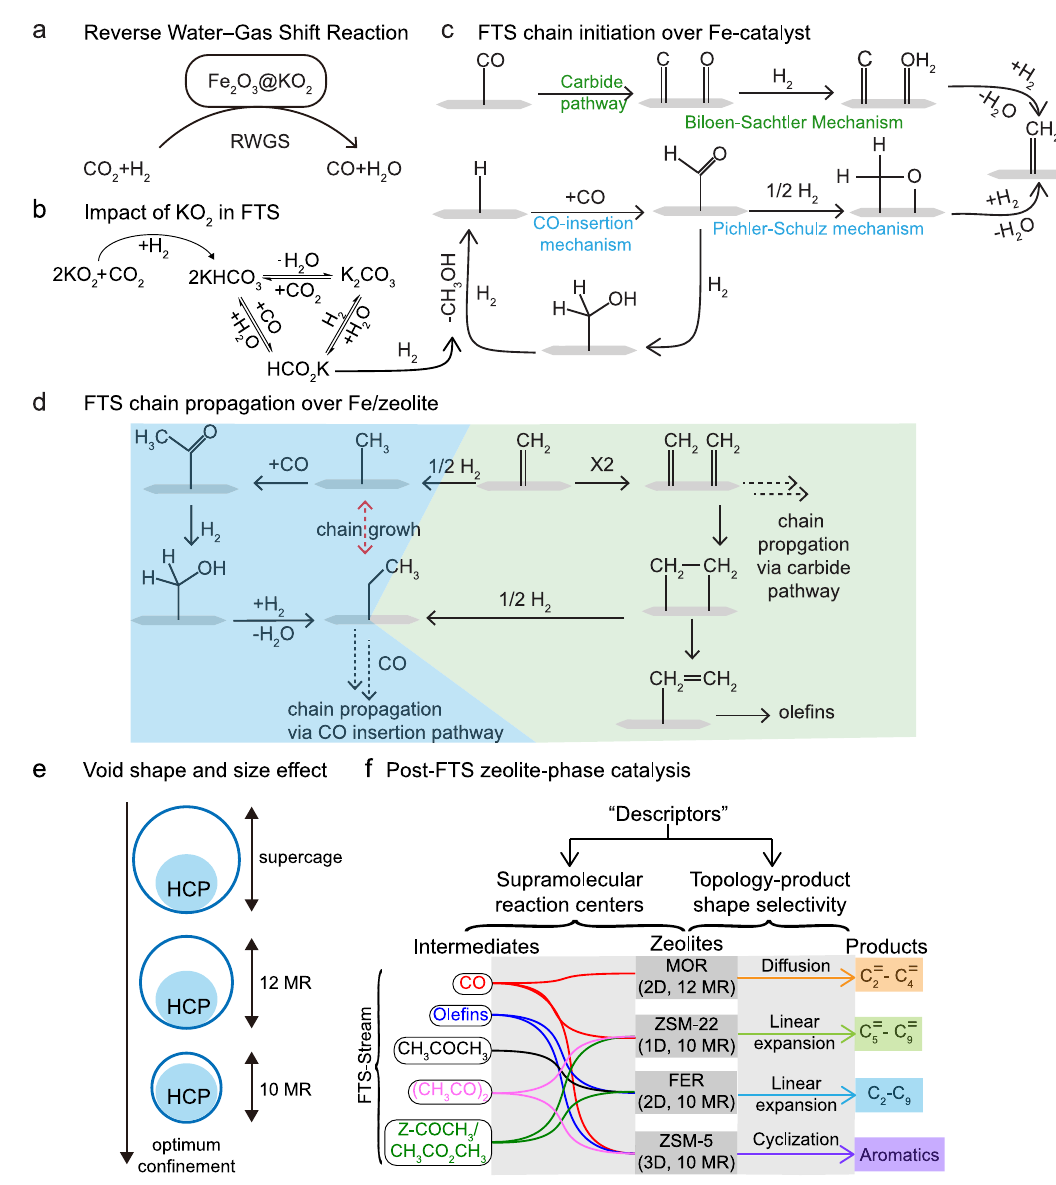
Fig. 7 The proposed mechanistic pathway for the Fe 2 O 3 @KO 2 /zeolite catalyzed hydrogenation of CO 2 , highlighting the ef fi cacy of our multifunctional system. The reaction sequence on a iron and b potassium phase of Fe 2 O 3 @KO 2 material implying the signi fi cance of tandem activation of CO 2 in this work. FTS-based c chain initiation and d chain propagation steps through both carbide and CO-insertion pathways; also known as Biloen – Sachtler mechanism (greenish background) and Pichler – Schulz mechanism (bluish background), respectively. e Simpli fi ed illustration highlighting the concepts of “ molecular fi t ” and “ containment effect ” in zeolite catalysis. f A simpli fi ed relationship sketch between hydrocarbons/carbonylates (including CO) and fi nal product selectivity for all zeolites, highlighting the signi fi cance of both supramolecular reaction centers and topology on controlling the product selectivity. (RWGS reverse water gas shift reaction, FTS Fischer – Tropsch Synthesis, HCP hydrocarbon